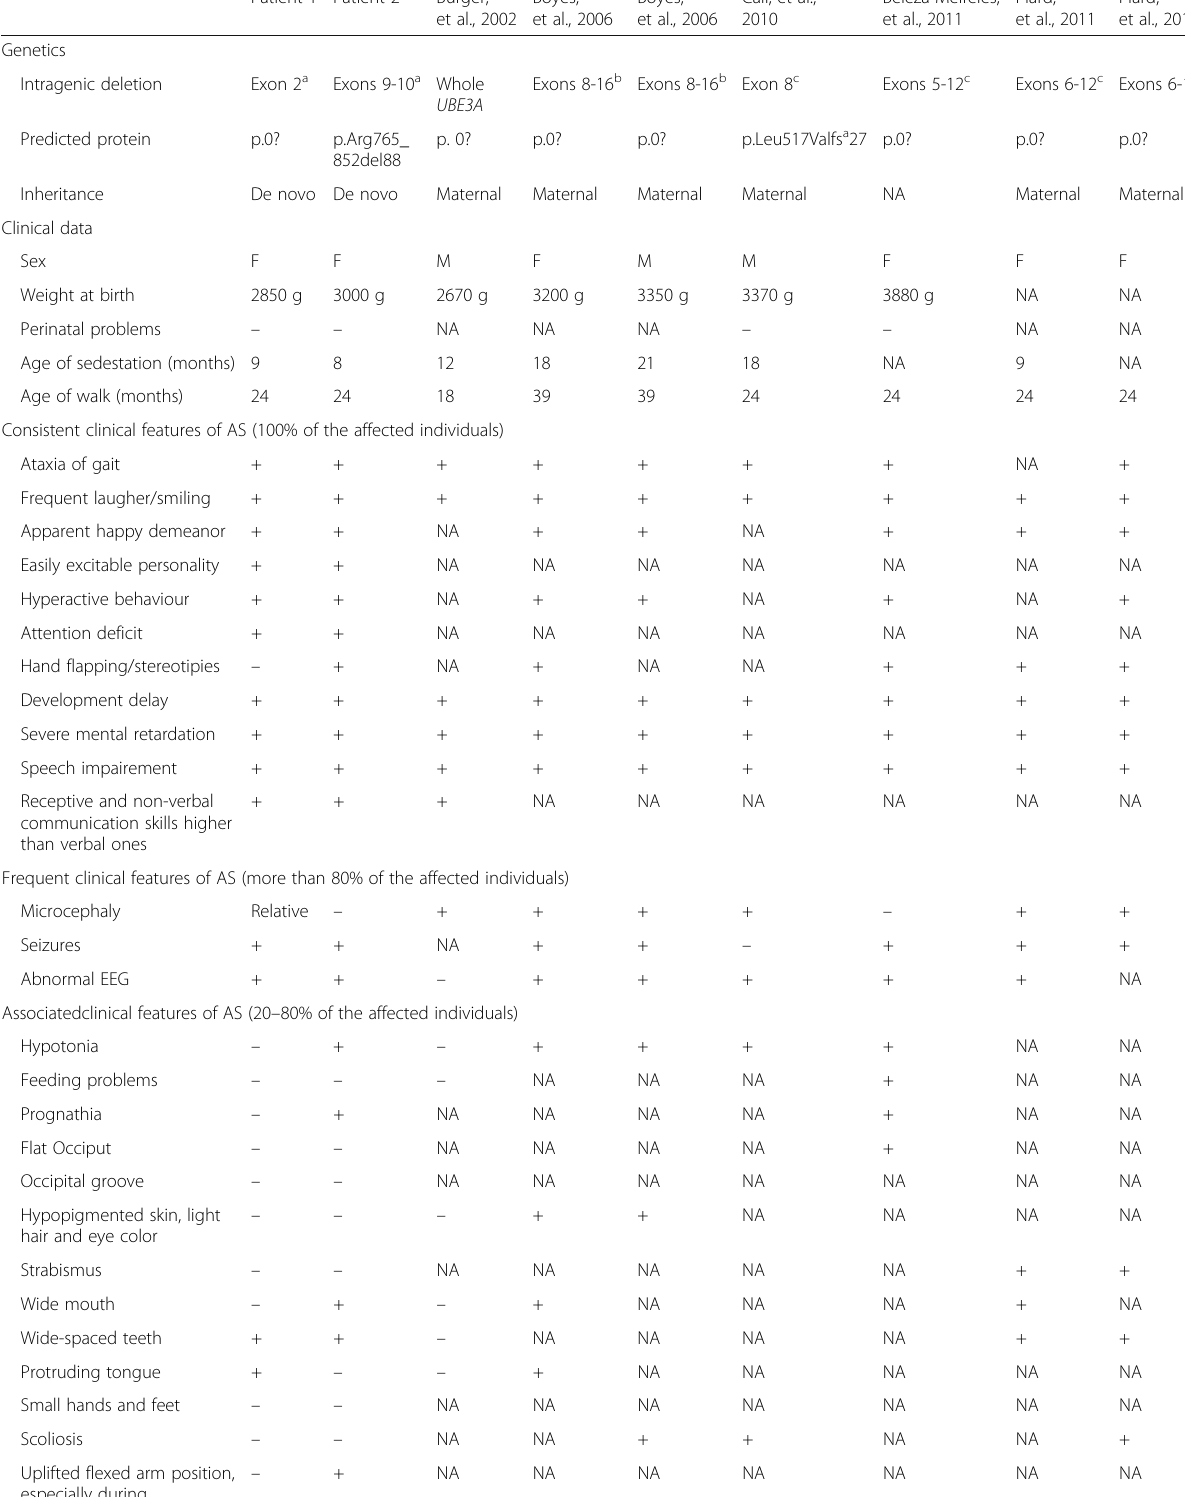
Table 1 Clinical data of patients with UBE3A intragenic deletions, following the clinical features of AS described by Williams et al.,